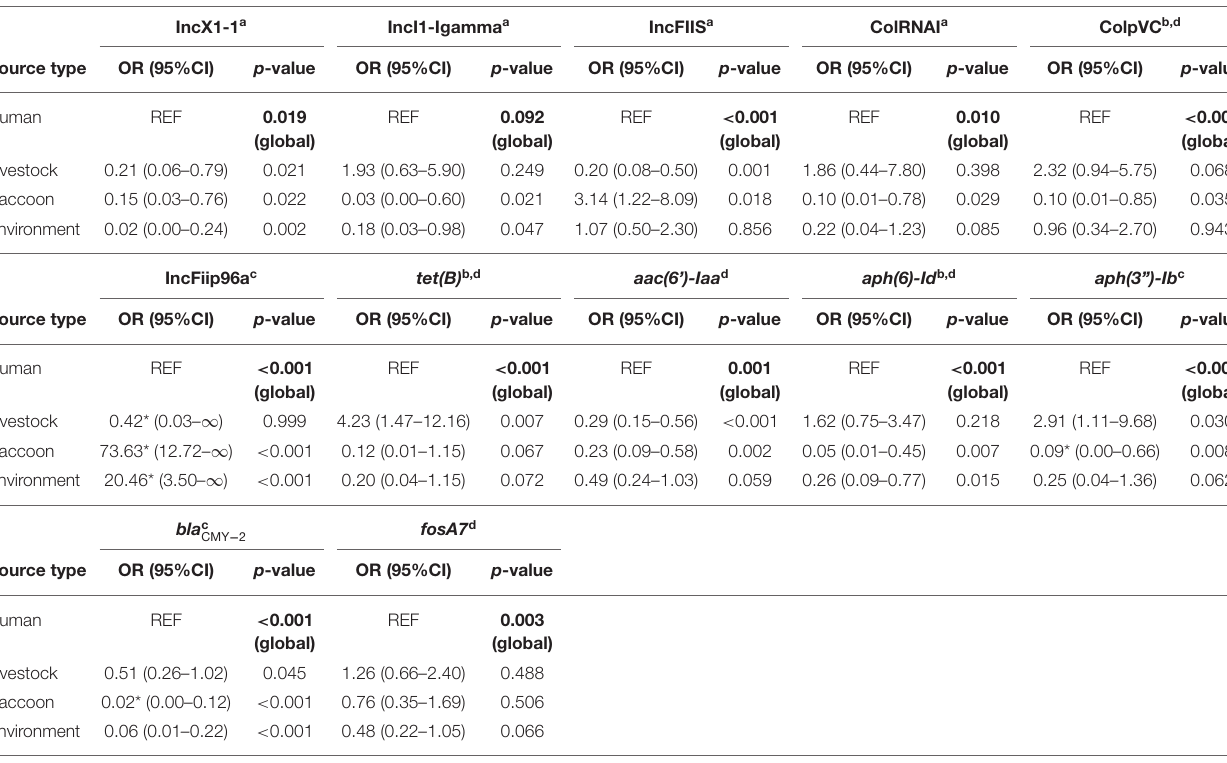
TABLE 5 | Logistic regression models assessing the association between source type and the occurrence of select antimicrobial resistance genes and predicted plasmids in Salmonella enterica isolates from raccoons, humans, livestock, and environmental sources in southern Ontario, Canada 2011 – 2013 ( n =